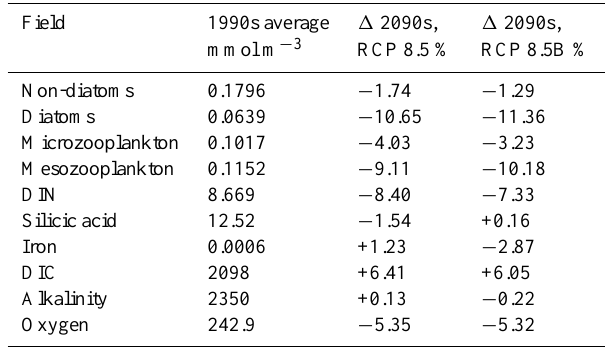
Table 3. Major biogeochemical fluxes, RCP 2.6 versus RCP 8.5. Table 4. Upper 100m tracer concentrations, RCP 8.5B versus RCP